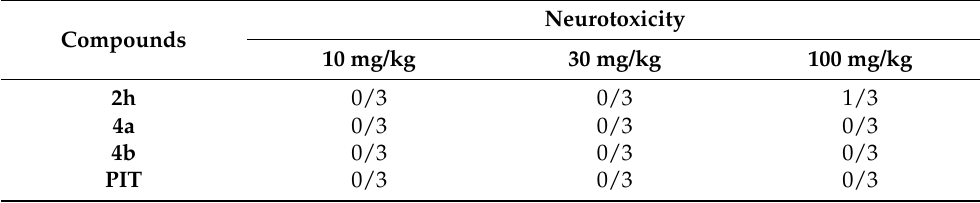
Table 2. The neurotoxicity of compounds 2h , 4a , and 4b (i.p.) in the rotarod test in mice. Compounds